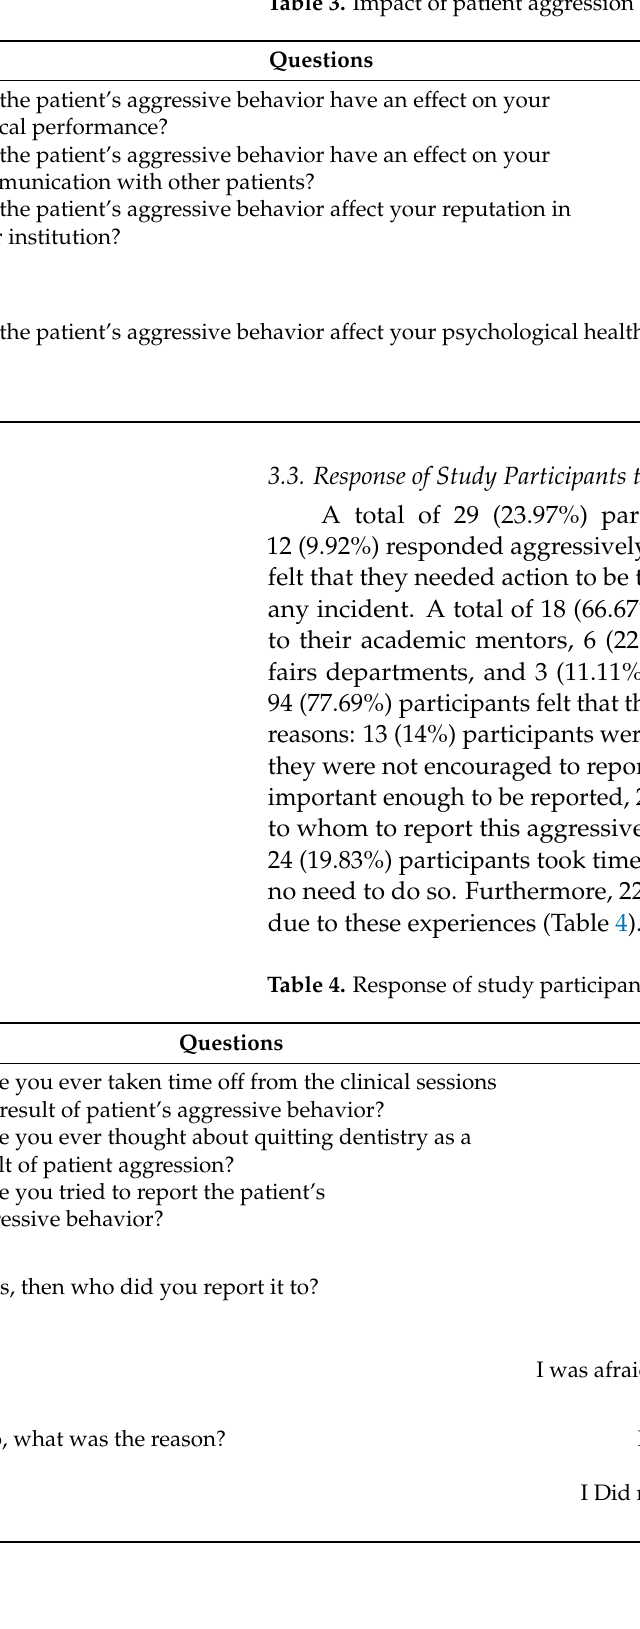
Table 3. Impact of patient aggression on study participants.